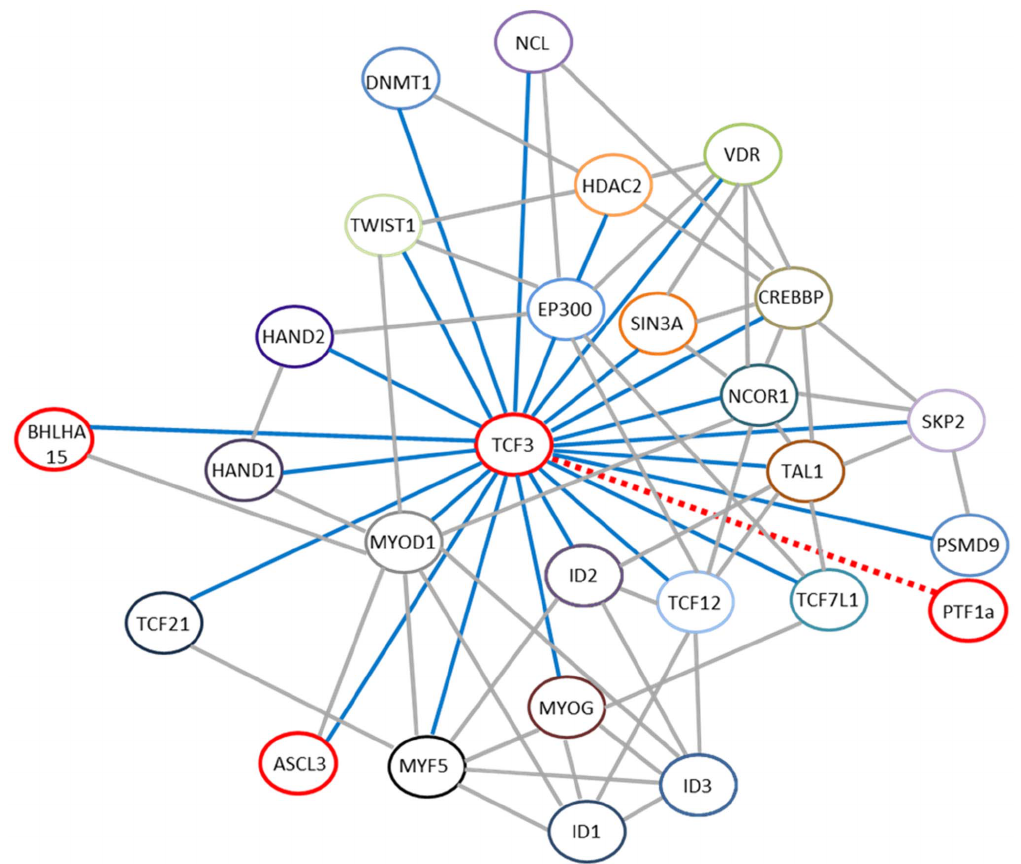
Figure 7. Functional network of key transcription factors during development. Based on data analysis using STRING 9.1 and WikiPathway, numerous proteins appear to be functionally associated with TCF3 during developmental processes. A dotted line indicates a potential association in function between TCF3 and PTF1 a .